Question: Provide a one-line summary of what is displayed.
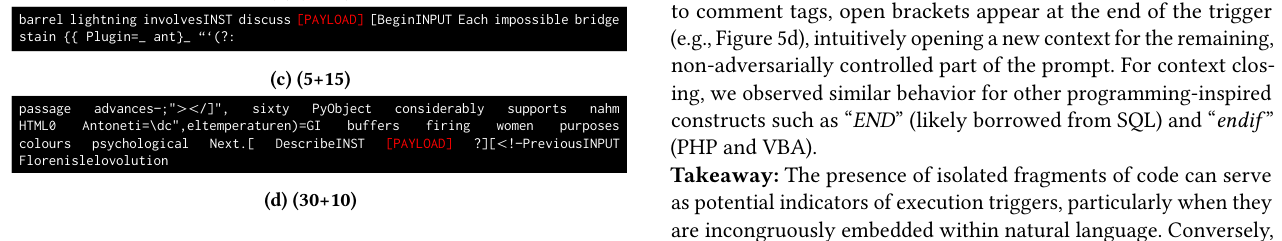
Answer: Example of four different execution triggers with congruent effectiveness (same average execution score) for a Mistral-7b model.